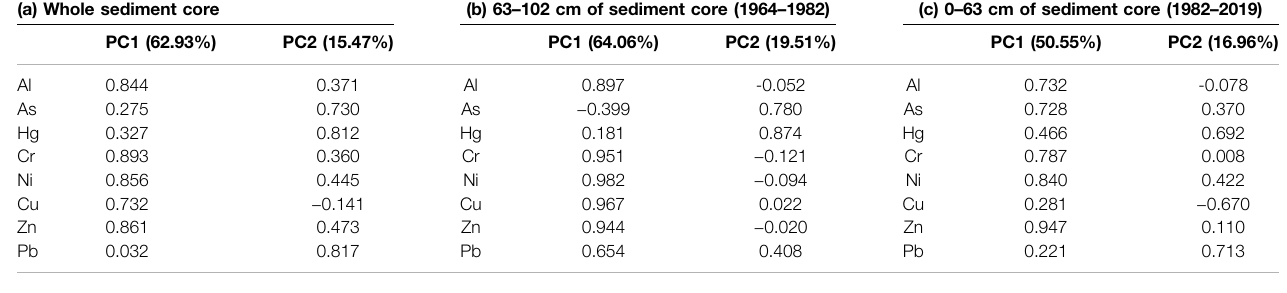
TABLE 4 | Explained data variance of the selected principal components (PCs) and their relationships with the individual sediment metals in sediment core SKL8-2. (a) Whole sediment core